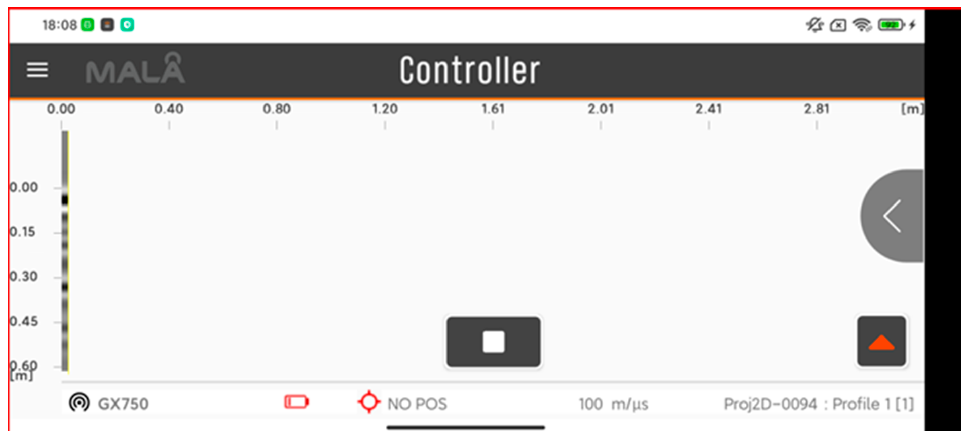
Figure 10. Image pixel coordinate diagram before reconstruction.